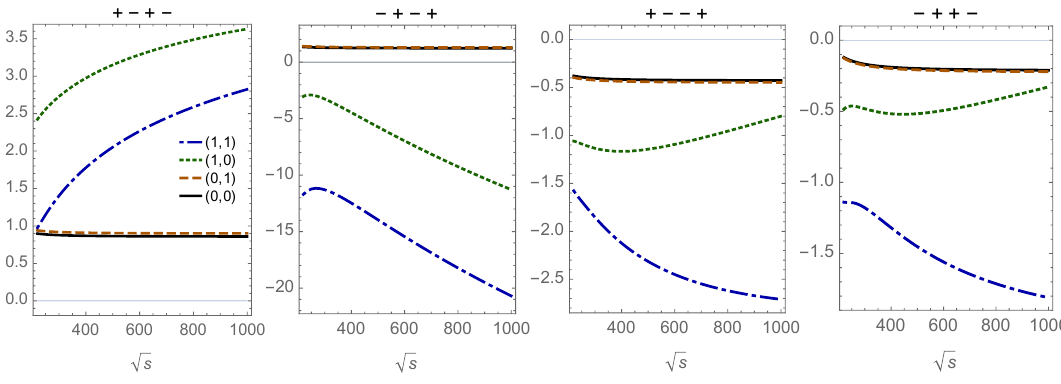
Figure 5 . Helicity amplitudes for u ¯ u → ‘ + ‘ − in dependence on the center-of-momentum energy √ for central scattering, cos θ = 0 , and µ R = s . The figure shows the real parts of the polarized hard scattering functions (finite remainders) Re H ( m,n ) / (4 π ) m + n , see eqs. (6.5)–(6.8), where the λ 1 λ 2 λ 3 λ 4 relative orders in the electroweak and strong couplings are denoted by ( m, n )